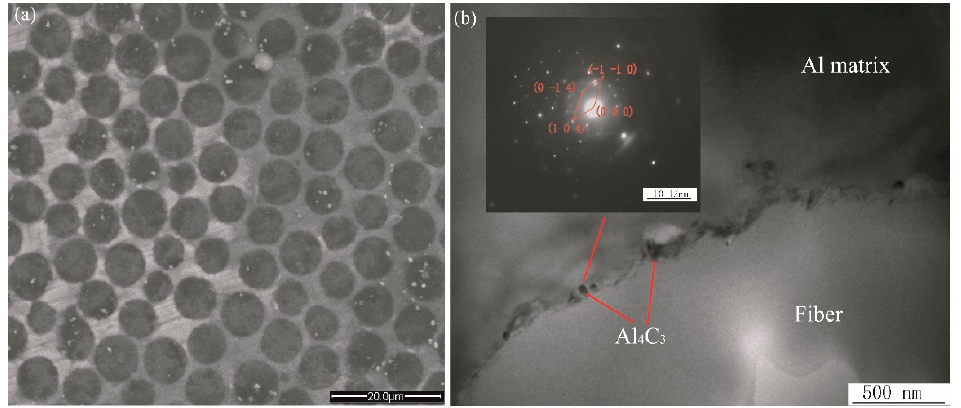
Figure 2. SEM micrograph of the CF/Al composite ( a ) and TEM micrograph of the fiber/matrix interface ( b ). The inset in Figure 2b is the SAED pattern taken at the Cf/Al interface.